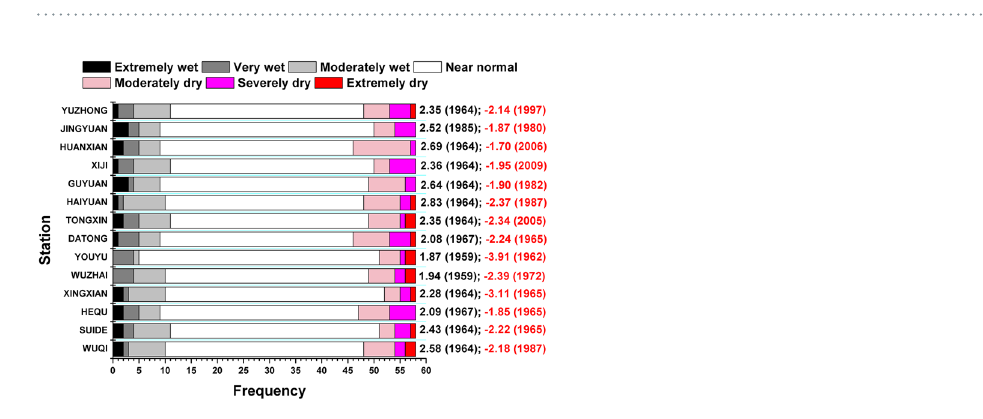
Figure 9. Different time scales of SPI (SPI-1, SPI-3, SPI-12) at 3 representative synoptic stations from 1958 to 2015.